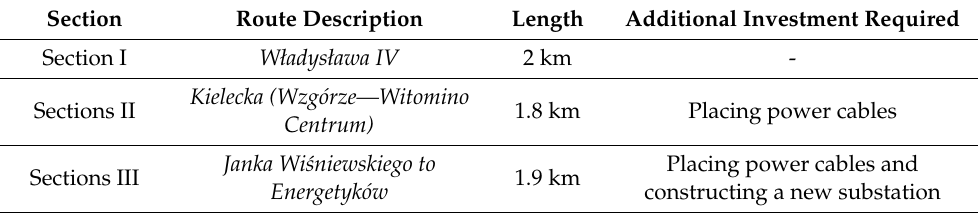
Figure 9. The possibilities (red lines) of extending the existing (black line) trolleybus network in Gdynia (source: own elaboration). Table 2. Comparison of the proposed section of overhead lines (OHL) (source: own elaboration).